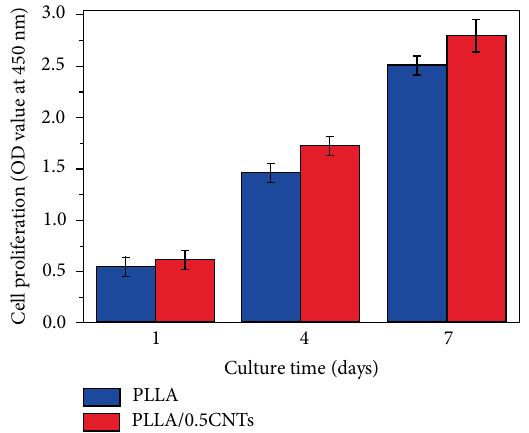
Figure 10: The obtained OD value using CCK-8 assays after 1, 4, 7 days’